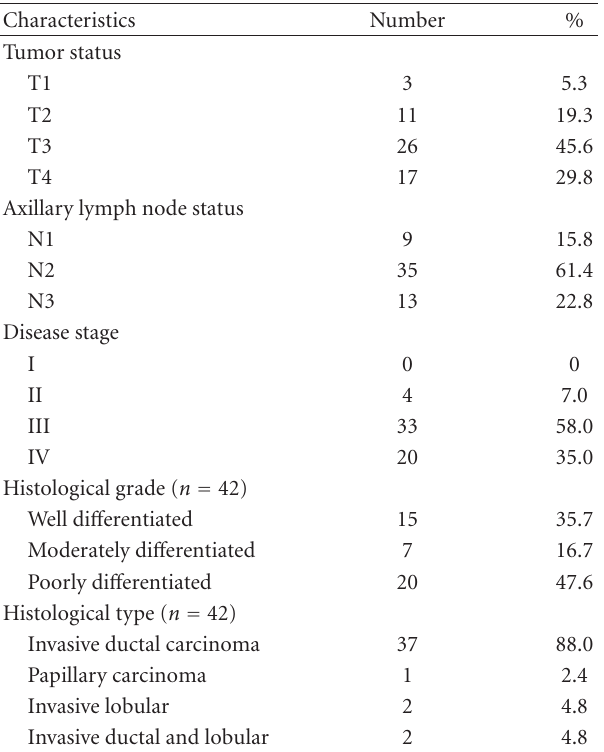
Table 3: Patient’s surgery and adjuvant treatments according to TNM